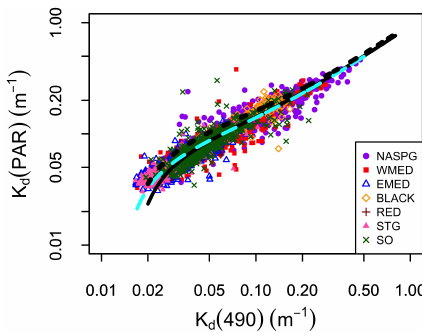
Figure 11. Comparison ( n = 658) between the diffuse attenuation coefficient for downward irradiance at 490nm as derived from satel- lite measurements ( K d (490) sat ) as a function of K d (490) derived from Biogeochemical-Argo float measurements within the first op- tical depth ( K d (490) in situ ). The solid line represents the 1:1 line. Biogeochemical-Argo data are grouped in seven major areas: Nor- wegian Sea, North Atlantic subpolar gyre and surrounding areas (NASPG); western Mediterranean Sea (WMED); eastern Mediter- ranean Sea (EMED); Black Sea (BLACK); Red Sea (RED); sub- tropical gyres and surrounding areas (STG); and Southern Ocean (SO). The RMSE and the median percentage difference (MPD) for all data are